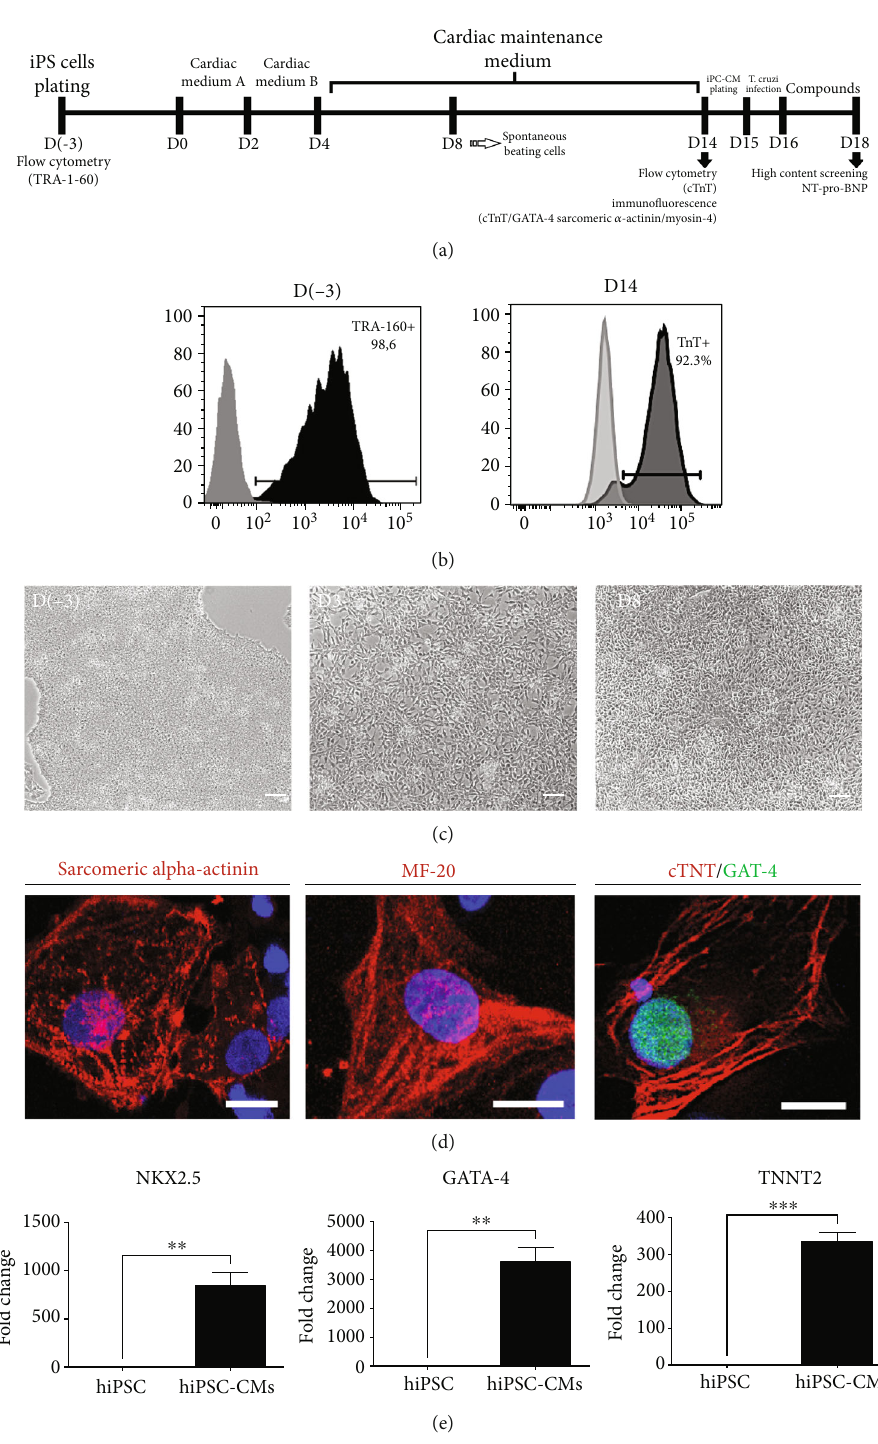
Figure 1: Cardiac di ff erentiation induction in hiPSC and characterization of hiPSC-CMs. (a) Schematic experimental design. (b) Flow cytometry analysis of hiPSCs at D(-3), before plating for cardiac induction, for TRA-1-60 expression, and hiPSC-CM purity at di ff erentiation D14 evaluated by cardiac troponin-T (cTNT) expression. Light grey histograms represent isotype controls. (c) Representative phase contrast micrographies of the di ff erent days postinduction of cardiac di ff erentiation from hiPSCs. Bars = 50 μ m . (d) Representative confocal microscopy images of hiPSC-CMs stained with sarcomeric alpha-actinin, sarcomeric myosin (MF-20), cardiac troponin T (cTNT), and GATA-4 (all in red). Nuclei were stained with DAPI (blue). Bars = 20 μ m . (e) Gene expression analysis by RT- qPCR demonstrating mRNA expression of cardiac genes NKX2.5 , GATA-4 , and TNNT2 , normalized to the levels of GAPDH . ∗∗ p < 0 : 01 ; ∗∗∗ p < 0 : 001